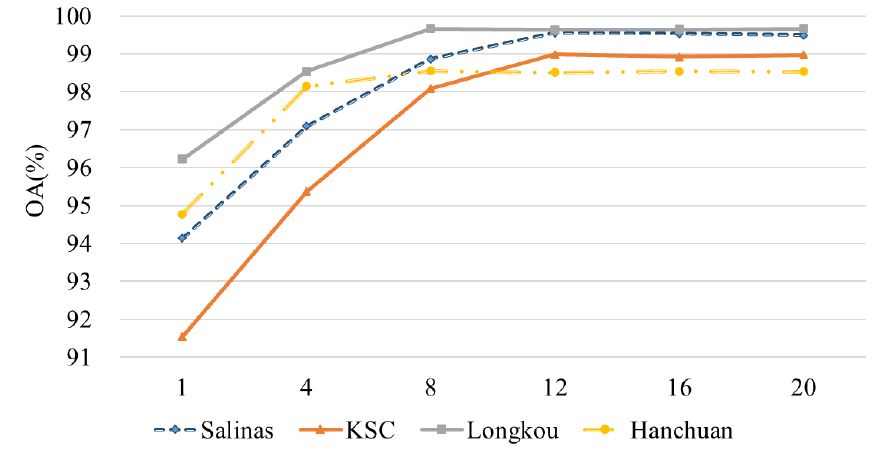
Figure 11. Results of DMLPFFN with different numbers of principal components.